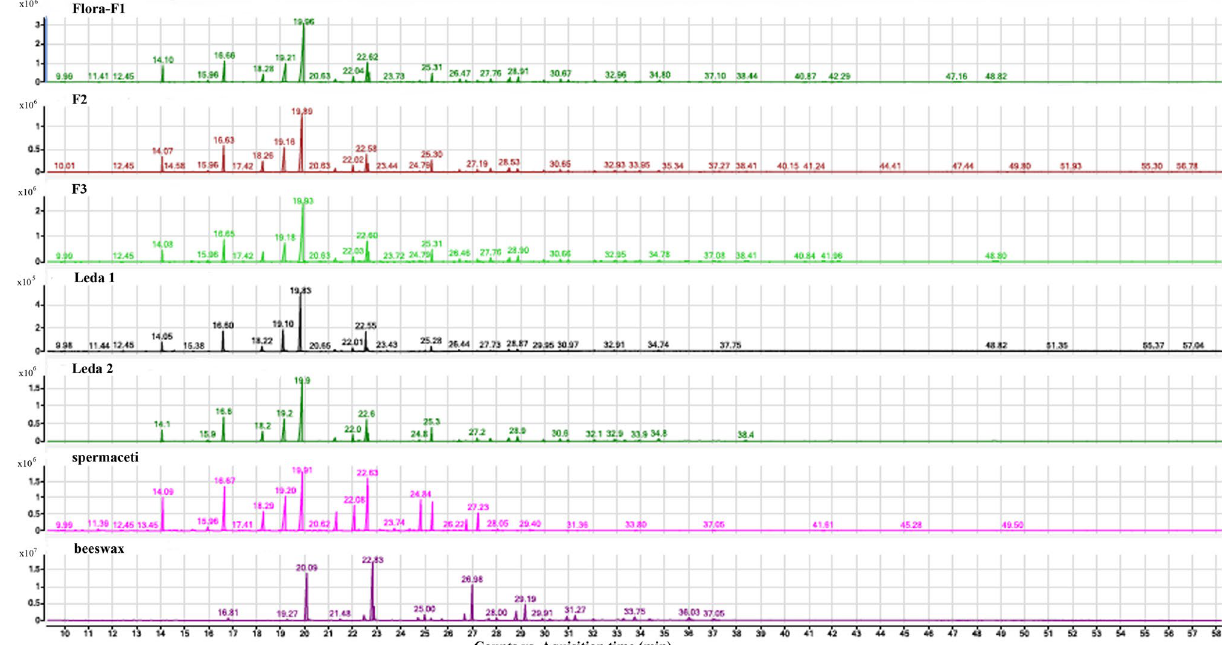
Figure 3. Chromatograms obtained after solvent extraction and derivatisation with MethPrepII (0.2 mol/L solution of m-tri-fluoromethylphenyl-trimethylammonium hydroxide in methanol) of the samples (from top to down): Flora F1–3, Leda 1–2 and the references spermaceti and beeswax.